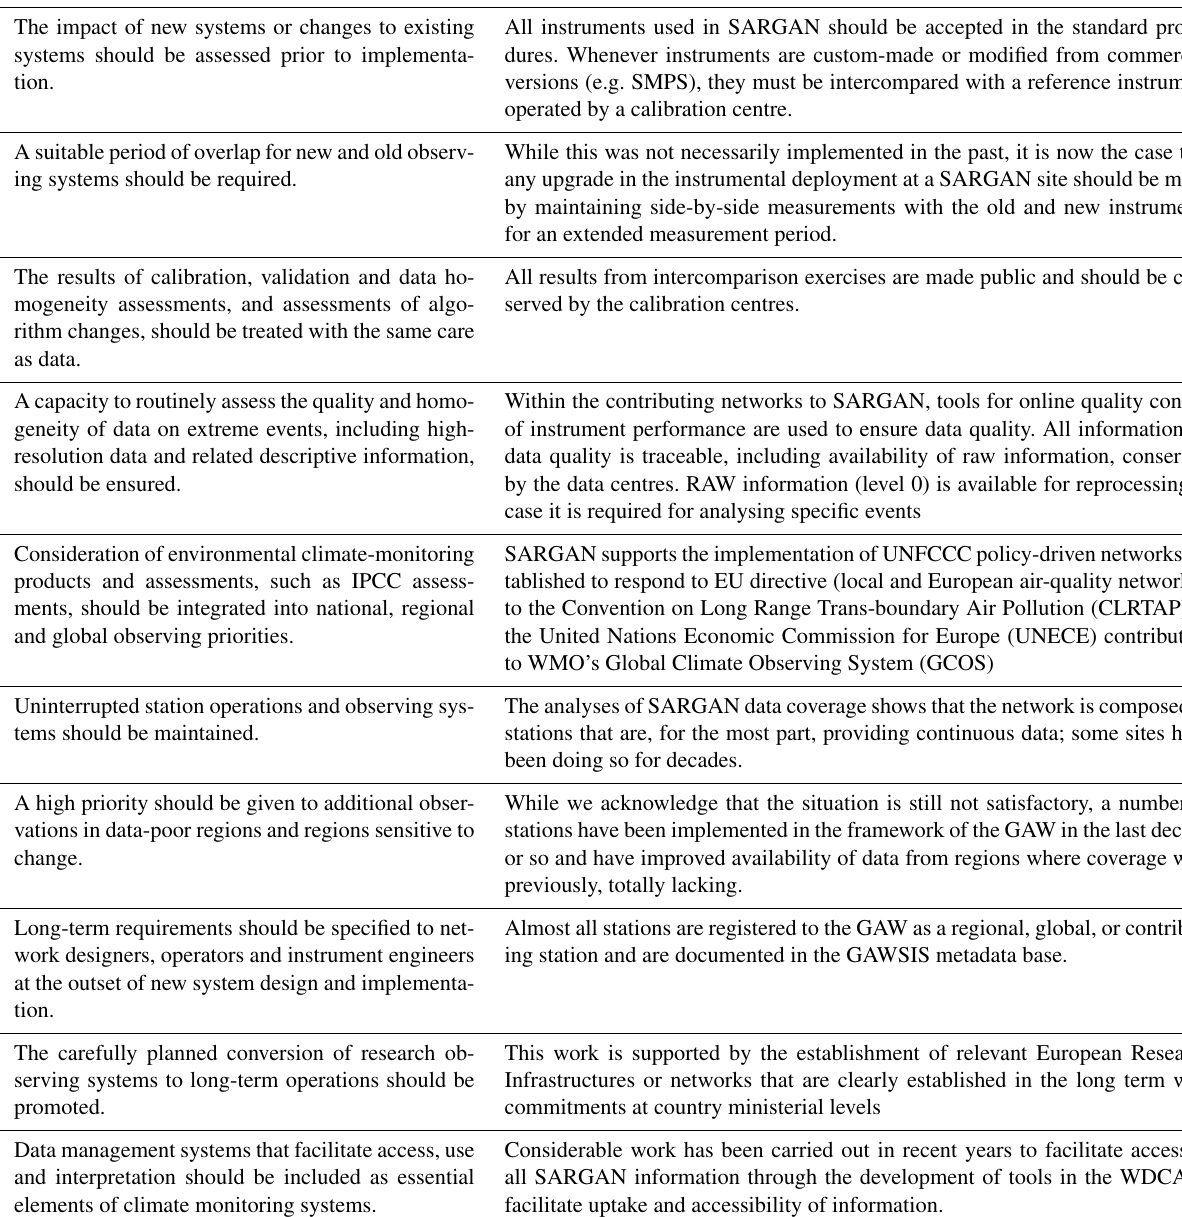
Table 4. A description of the status of SARGAN with respect to the requirements for GCOS networks. GCOS